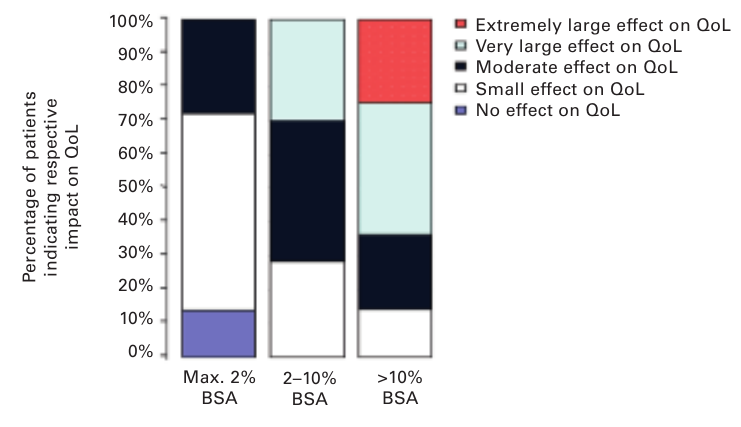
Extremely large effect on QoL Very large effect on